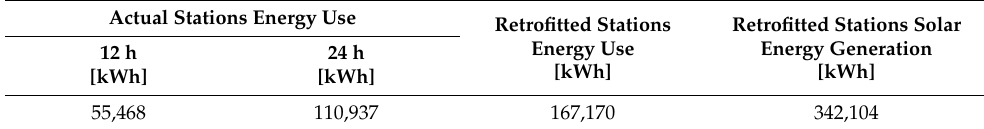
Table 6. Annual energy savings scenarios in CU-UNAM with solar